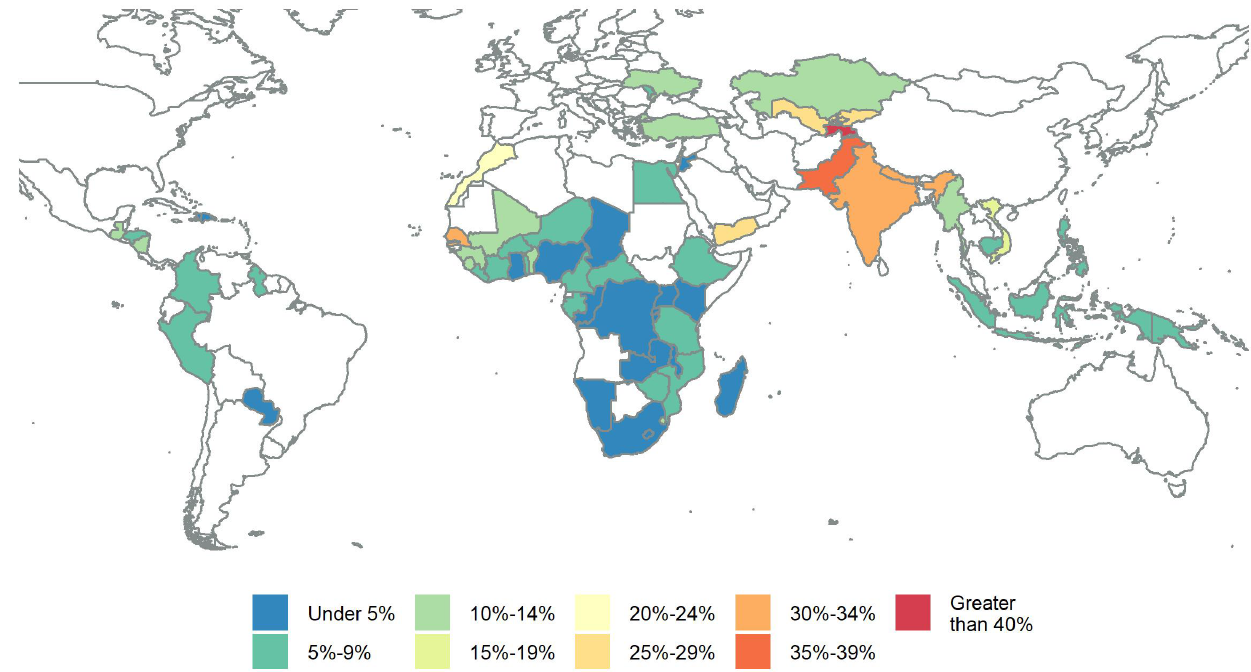
Figure 1. Map of the proportion of married women living with their mother-in-law countries with The Demographic and Health Surveys